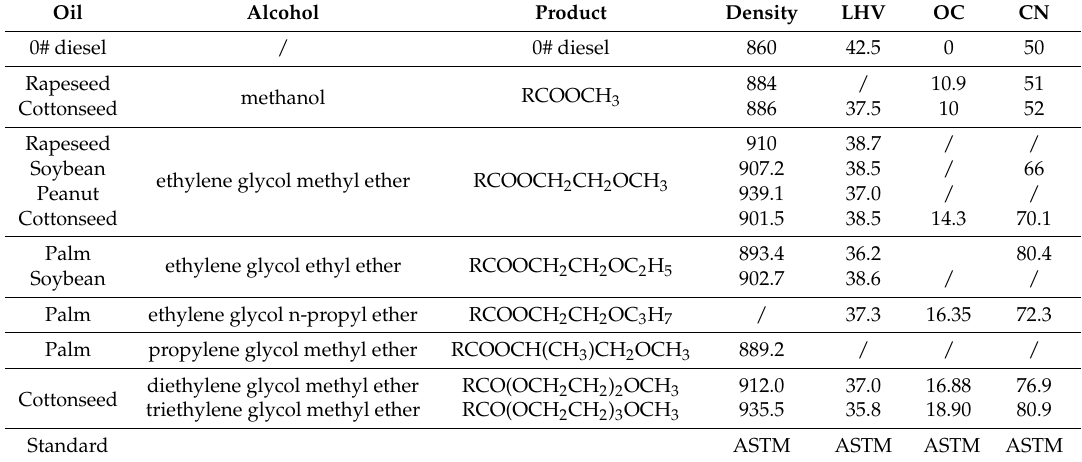
Table 1. New models of biodiesels and some of their fuel properties [32–50].